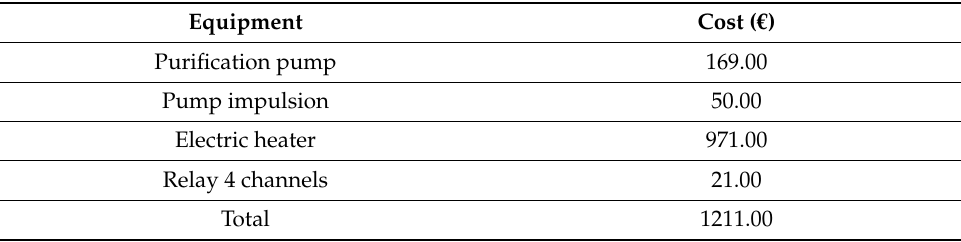
Table 2. Cost of installed equipment scenario